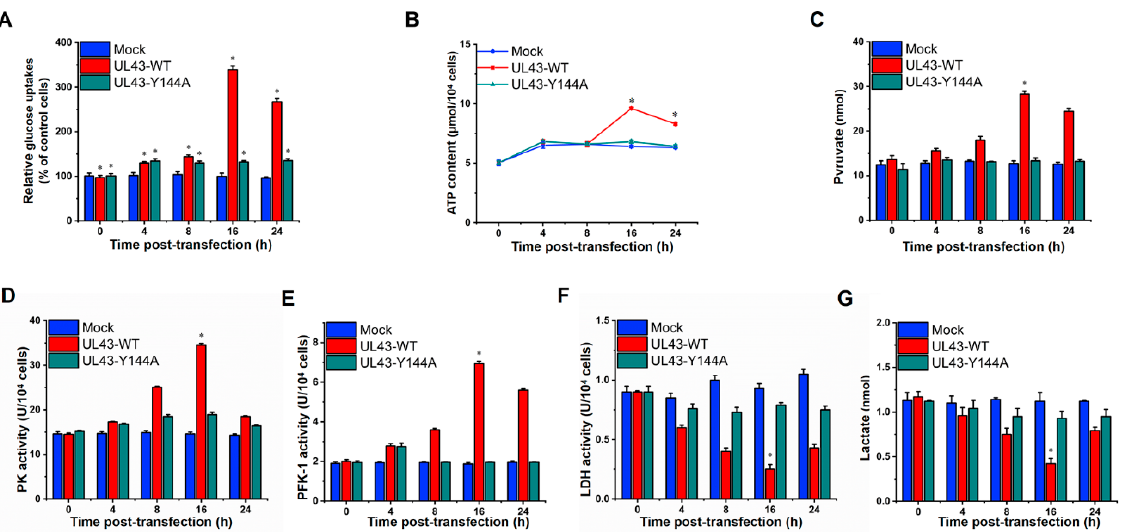
Figure 4. UL43-transfection induces aerobic oxiation of glucose. The oxidative metabolism levels of UL43-WT, UL43-Y144A and Mock cells were detected at 0, 4, 8, 16 and 24 h. ( A ) Relative glucose uptake analysis. ( B , C ) Analysis of ATP content and pyruvate level. ( D – F ) Enzyme activity detection of PK, PFK-1, LDH. ( G ) Analysis of lactate level. *: p < 0.05 vs. other